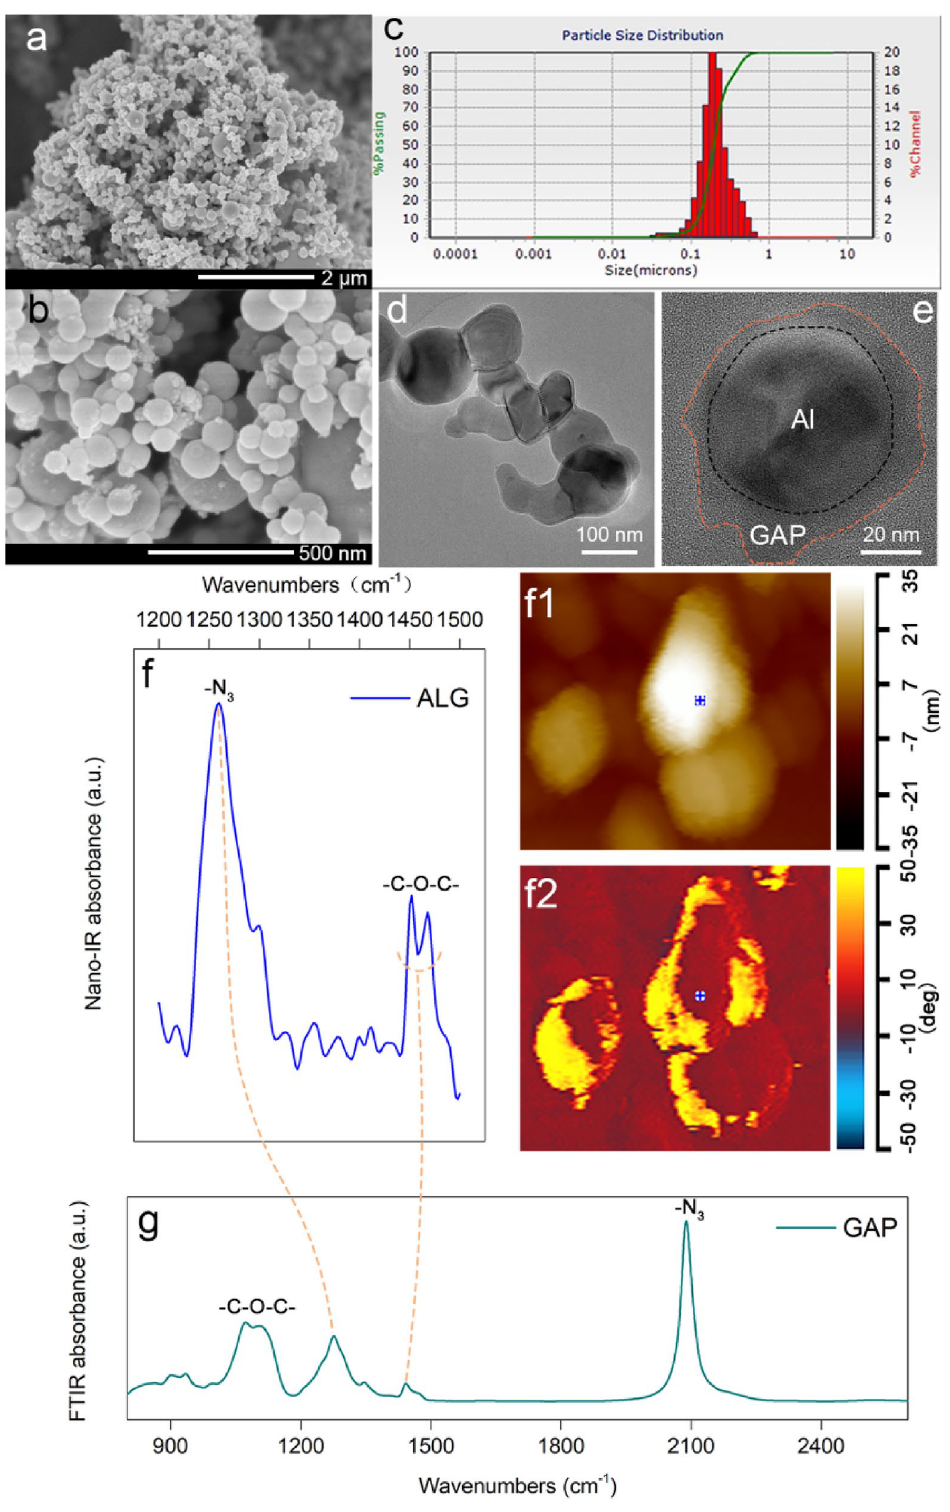
Figure 1. Scanning electron microscopy (SEM), transmission electron microscopy(TEM), nano-IR and FTIR spectra of the ALG. ( a , b ) are the SEM images; ( c ) is laser grain size distribution; ( d , e ) are the TEM images; ( f ) is the corresponding nano-IR spectrum of the blue spot in heigh image ( f1 ) and phase image ( f2 ); ( g ) the FTIR spectrum of the